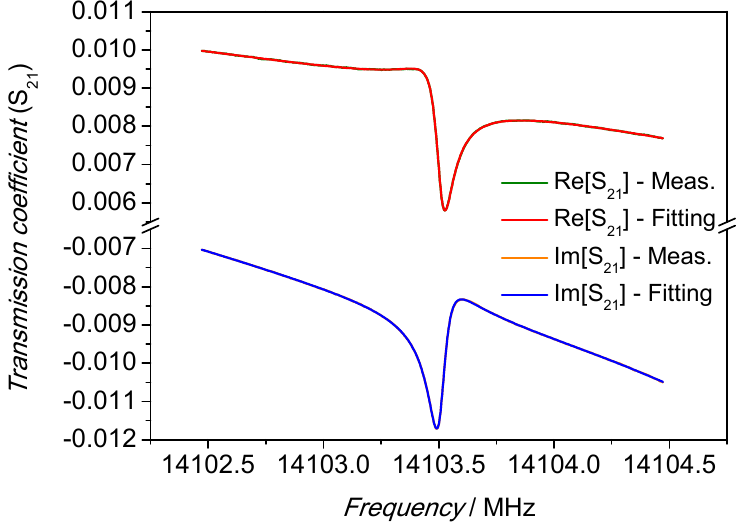
Figure 6. Lorentzian fitting of the frequency spectrum: real and imaginary part. The spectrum was acquired with a resolution of 2.5 kHz. In both cases the fitted functions are perfectly superimposed to the acquired data points.